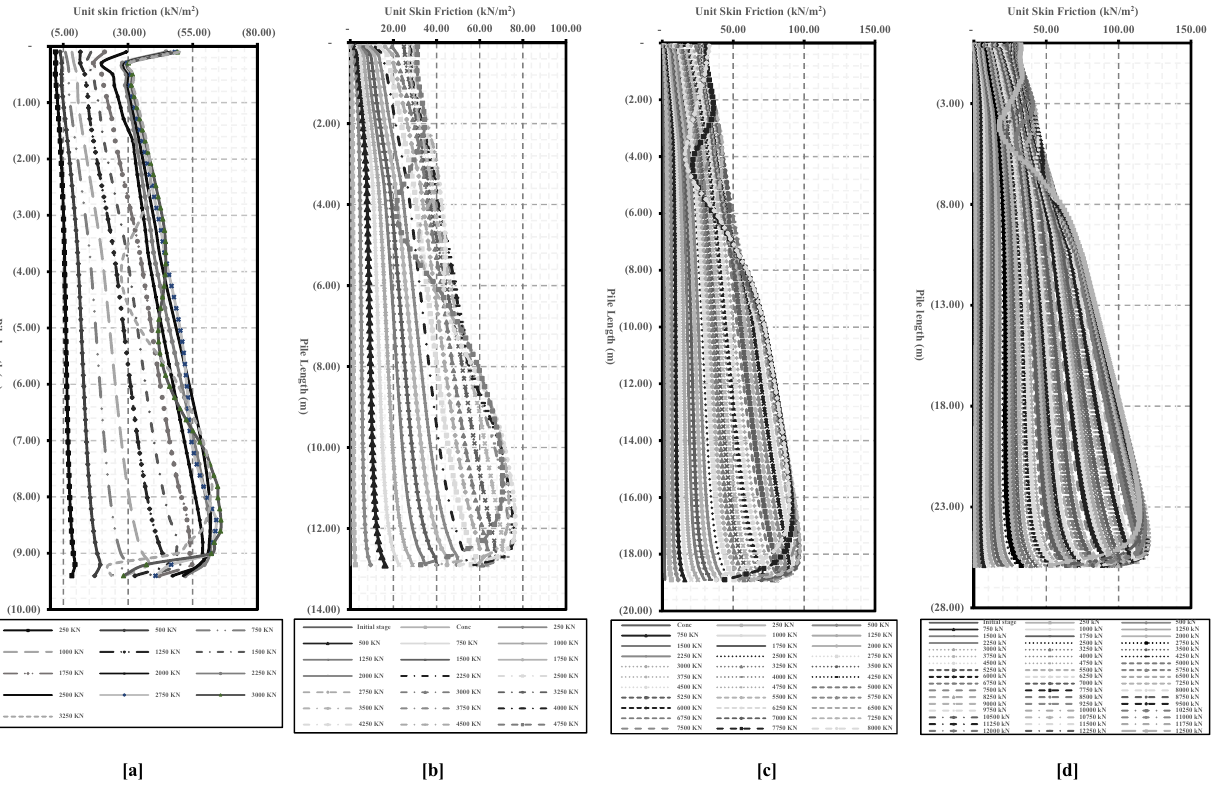
Figure 12. Results of unit skin friction distribution with depth obtained using four numerical models with different lengths. ( a ) Length of 9.50 m. ( b ) Length of 13.0 m. ( c ) Length of 19.0 m. ( d ) Length of 26.0 m.